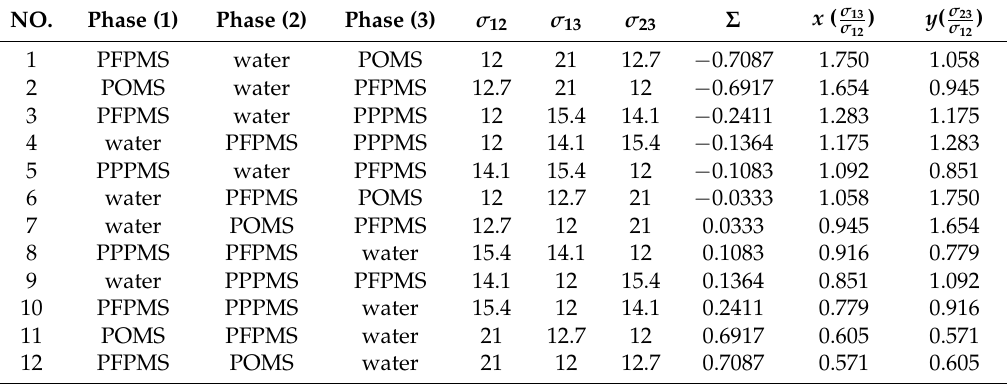
Interfacial tension